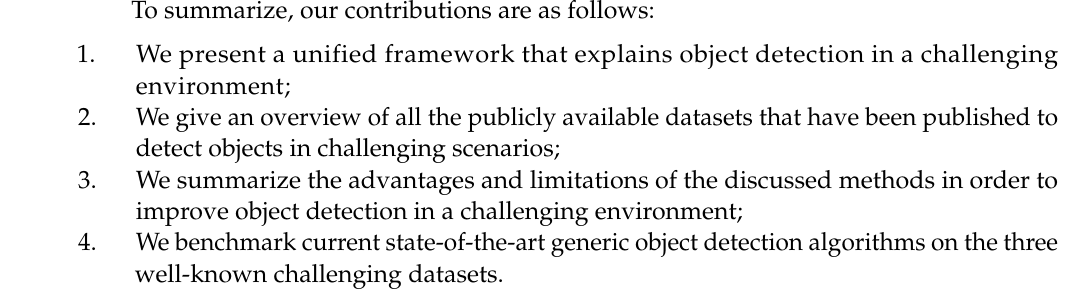
Figure 4. A timeline view of different deep learning approaches developed recently to improve object detection in challenging